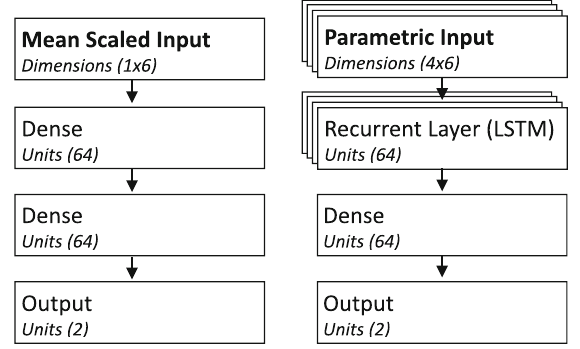
ground events (MSCWO, MSCLO), the reconstructed depth of the shower maximum in the atmosphere X max and the (cid:3) E/E parameter, calculated as the averaged spread in energy reconstruction between. These input parameters are similar to those used in the BDT method of [19], and hence